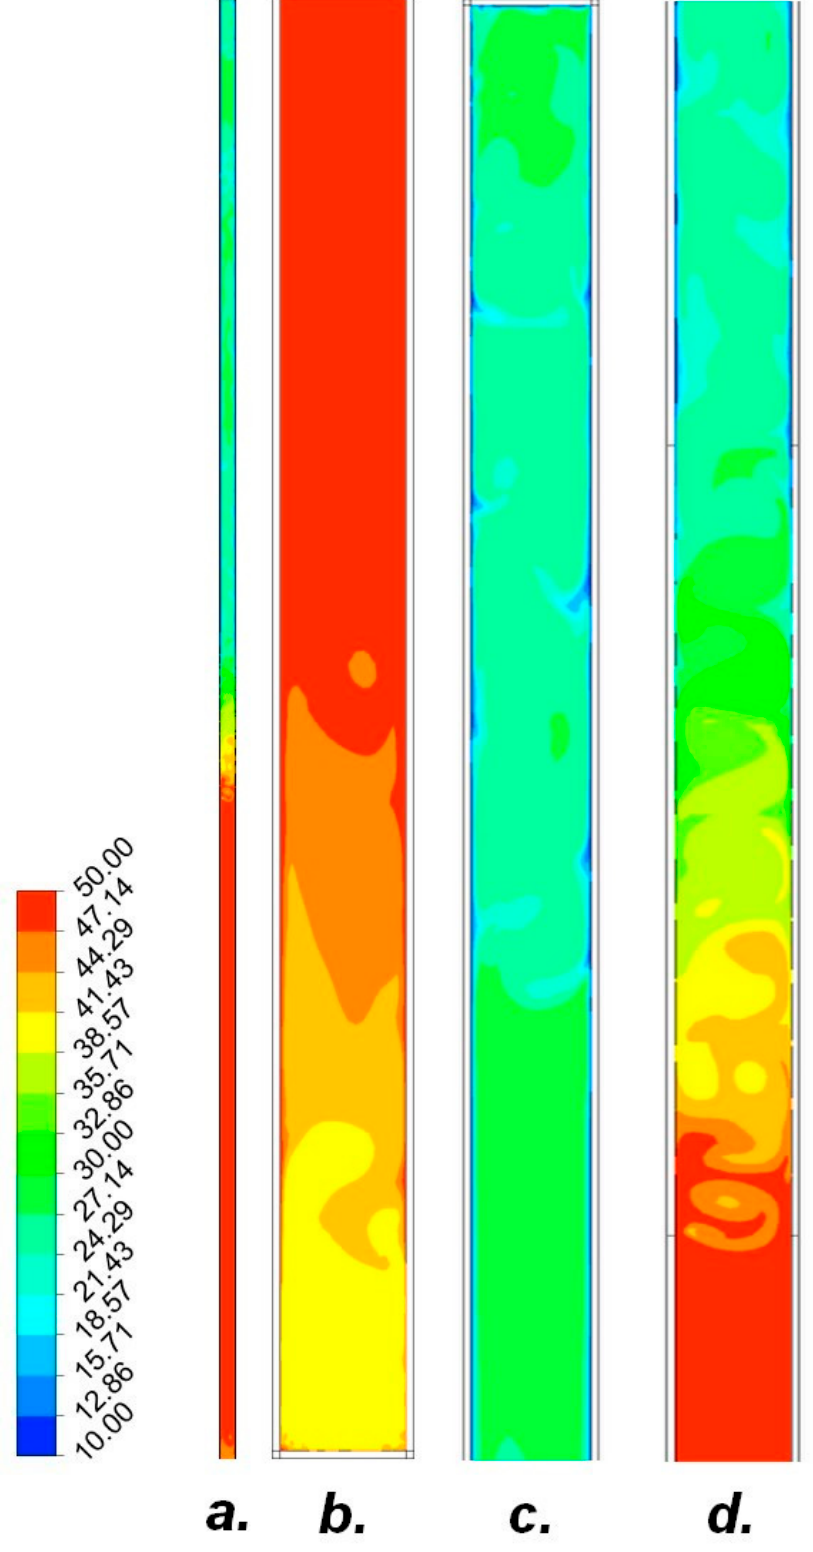
Figure 12. Temperature distribution in the heat pipe. ( a ) Total heat pipe; ( b ) evaporator section; ( c ) condenser section; ( d ) isothermal section.